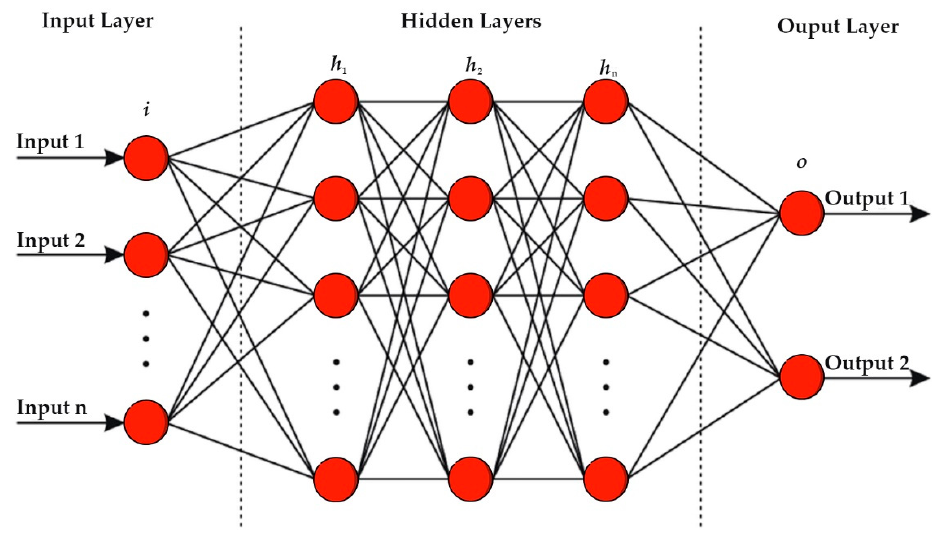
Figure 5. Artificial neural networks.